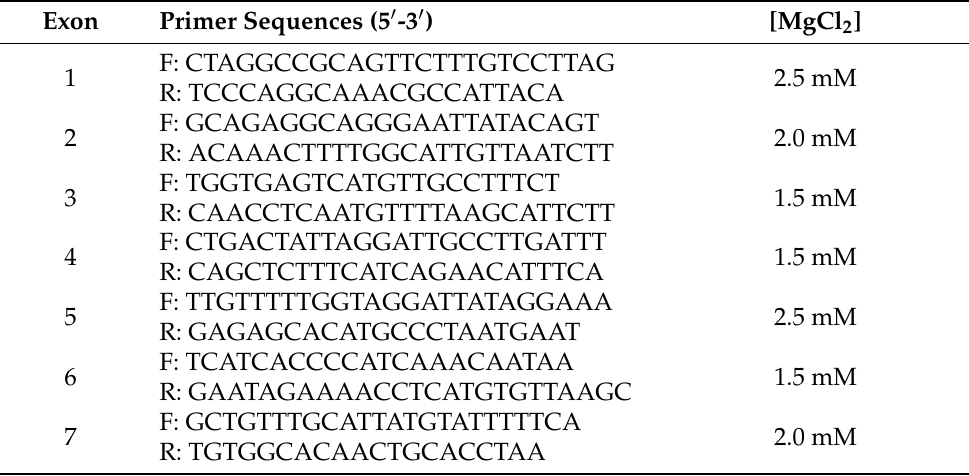
Table 1. Primers and conditions for PCR amplification of all exons of PJVK